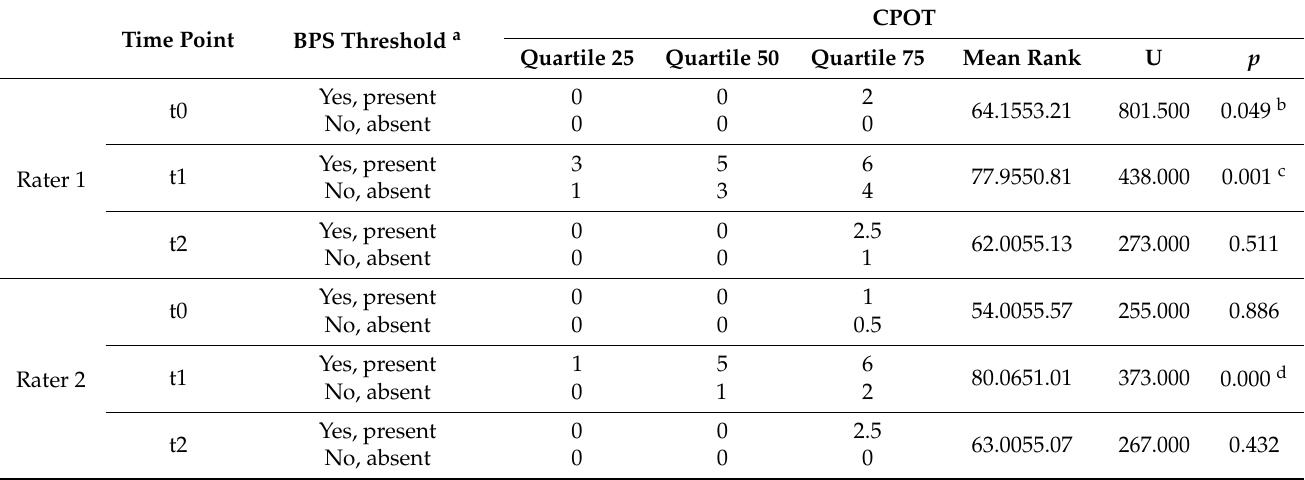
Table 3. CPOT scores in patients with and without pain according to the Behavioural Pain Scale threshold for Rater 1 and Rater 2 at each time